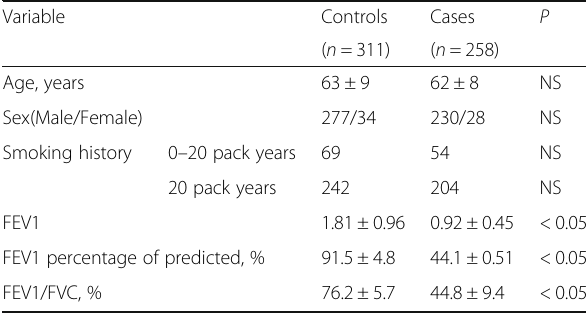
Table 1 Description of study population